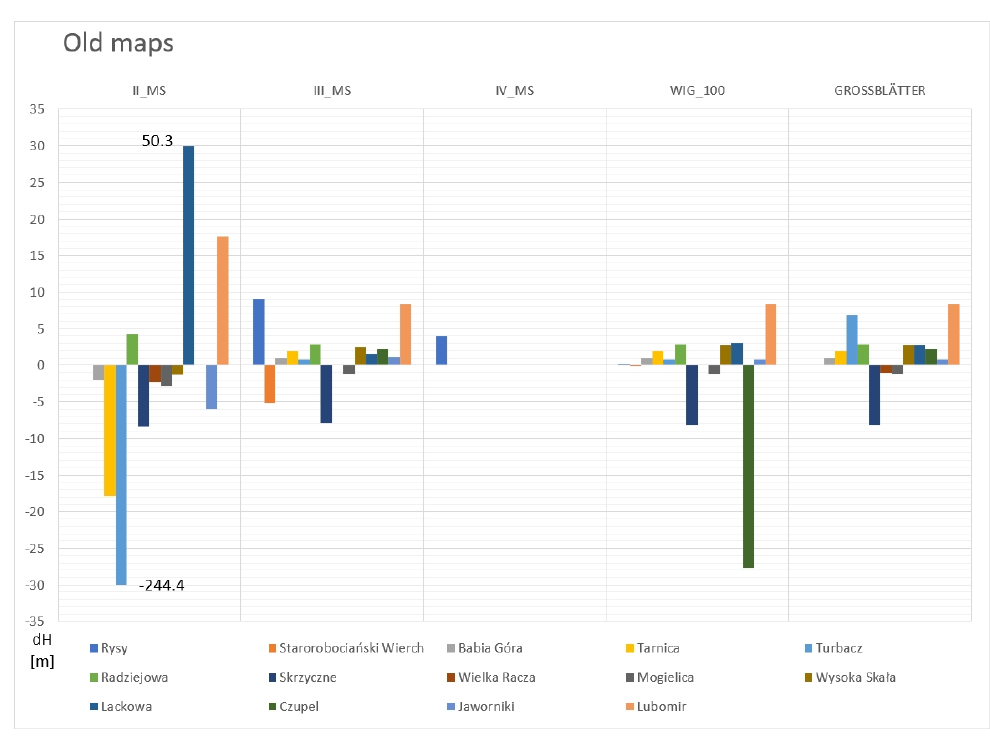
Figure A7. Height difference with GNSS surveying for old maps. Source: authors.